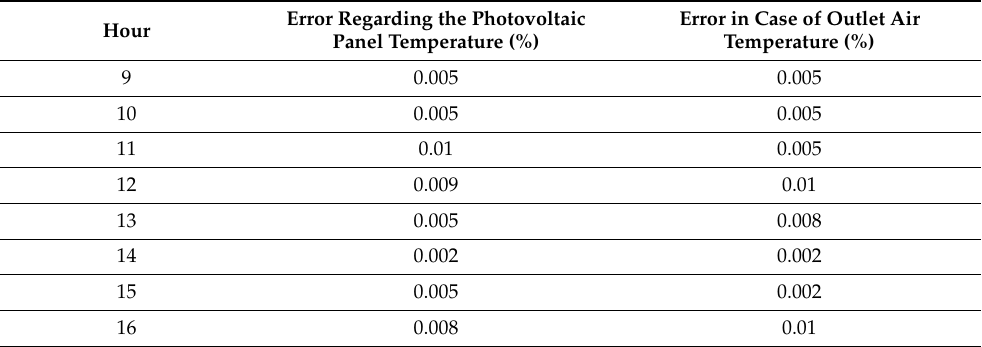
Figure 3. Evaluation of the validity of the results by comparing the current results and the results of the studied reference. Table 2. Calculated errors for the studied parameters.